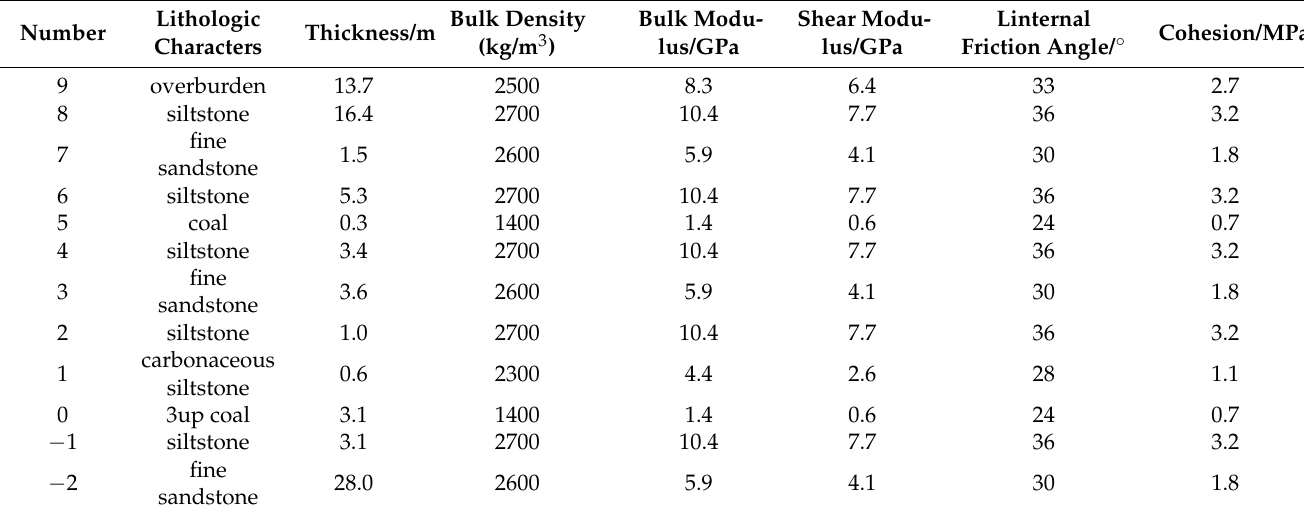
Table 1. Numerical simulation of rock stratum and lithology